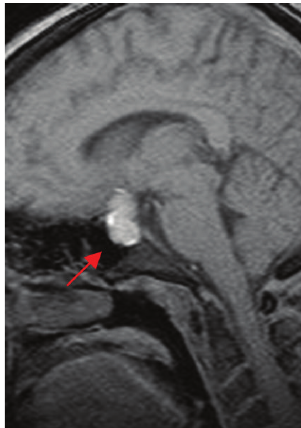
Figure 1: Sagittal T1 MRI of brain without contrast shows area of hyperintensity within the sella and suprasellar regions (red arrow). This likely represents pituitary apoplexy within the known macroadenoma.